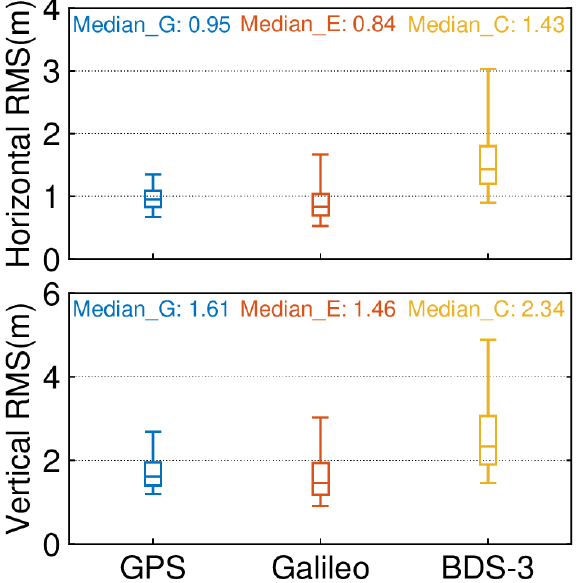
Figure 11. Boxplot of position accuracy of dual-frequency ionosphere-free combined SPP with an elevation cut-off of 7° for GPS, Galileo, and BDS-3.